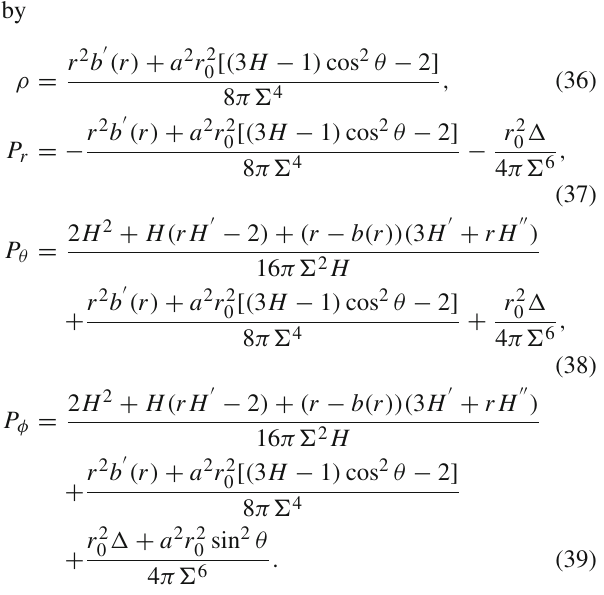
the above condition would reduce to ρ (cid:2) 0 and ρ + P r (cid:2)